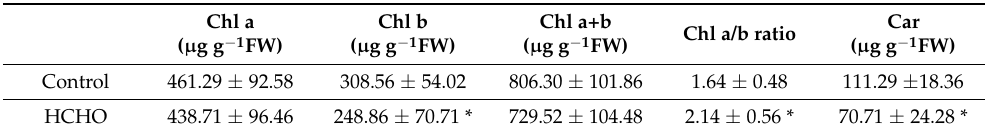
Table 1. Effect of treatment with gaseous formaldehyde applied as 20 mg m − 3 on photosynthetic pigment content: Chl a, Chl b, Chl a+b, and Car, as well as Chl a to Chl b ratio in C. comosum leaf tissues after 48 h of plant Figure 3. Effect of treatment with gaseous formaldehyde applied as 20 mg m − 3 on AspAT and AlaAT activities in C. comosum leaf tissues after the 48 h of plant exposure. The data are means ± SD. * indicates values that differ significantly from the control at p < 0.05.